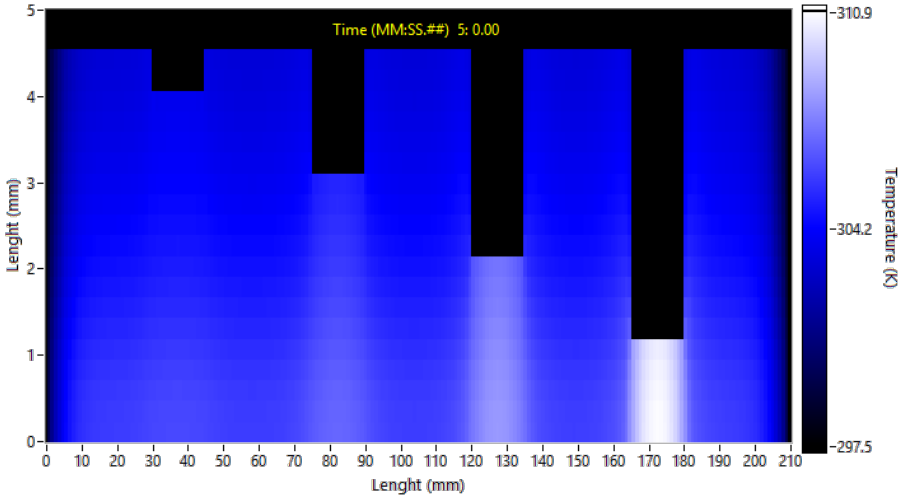
Figure 4. Temperature distribution after the initial simulation, 15 cycles of 20 s each. The temperature profiles from the laboratory tests and simulation (Figure 5) show a significant difference. In the laboratory tests, the maximum temperatures are higher than in simulations. This is due to the reflected radiation from the stimulation. For the lower stimulation amplitude, the reflected radiation is almost null. This makes the temperatures in the laboratory tests and simulations very close. As a result, the stimulation amplitude value was set to approximate the temperatures in the lower part of the cycles (valleys).